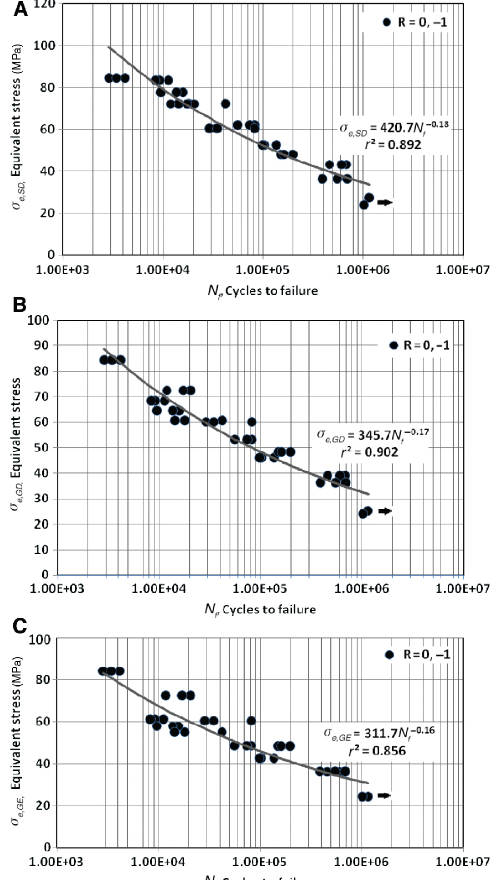
Figure 9: (A) Soderberg ’ s equivalent stress vs the number of cycles to failure of the friction stir welded T-joint of 19501 aluminium alloy. (B) Goodman ’ s equivalent stress vs the number of cycles to the failure of friction stir welded T-joint of 19501 aluminium alloy. (C) Gerber ’ s equivalent stress vs the number of cycles to failure of the friction stir welded T-joint of 19501 aluminium